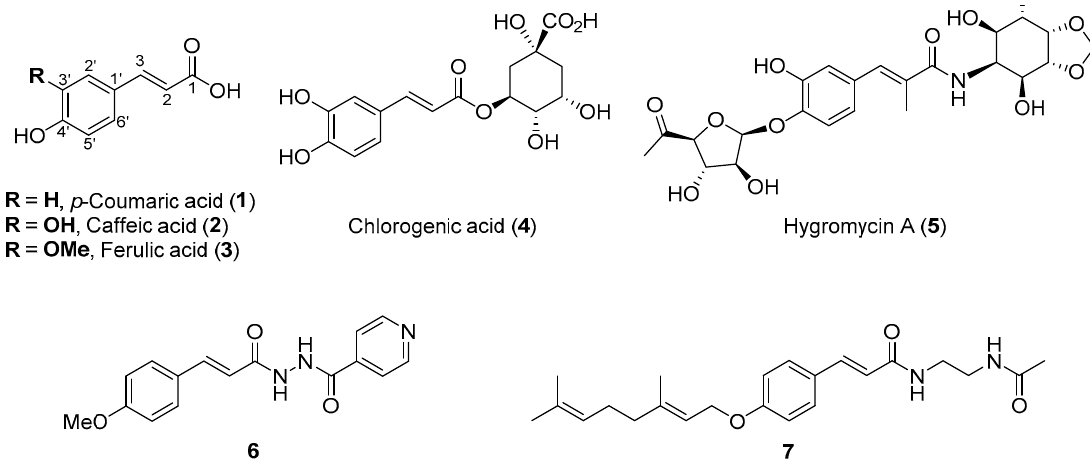
Figure 1. Natural and synthetic HCAs showing antibacterial activity.